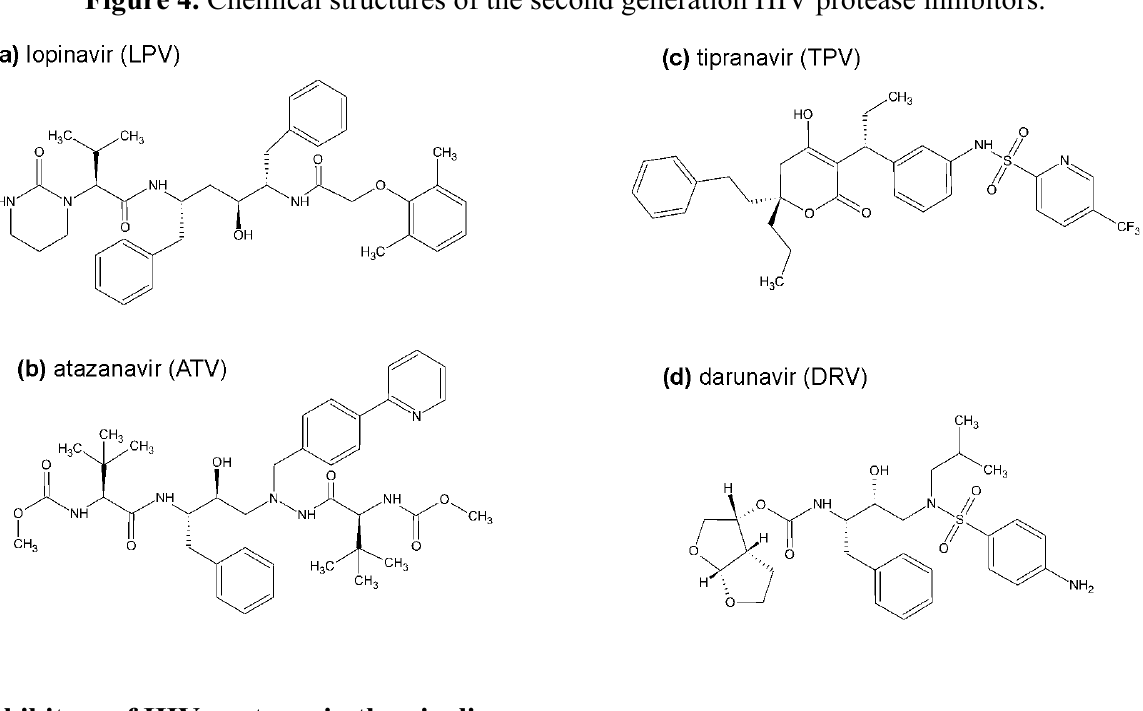
Figure 4. Chemical structures of the second generation HIV protease